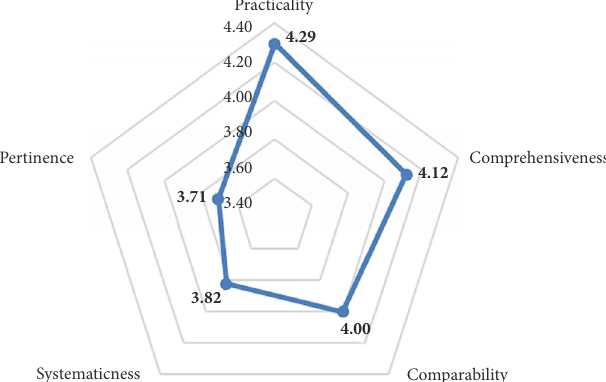
Figure 2. Evaluation results of the assessment index